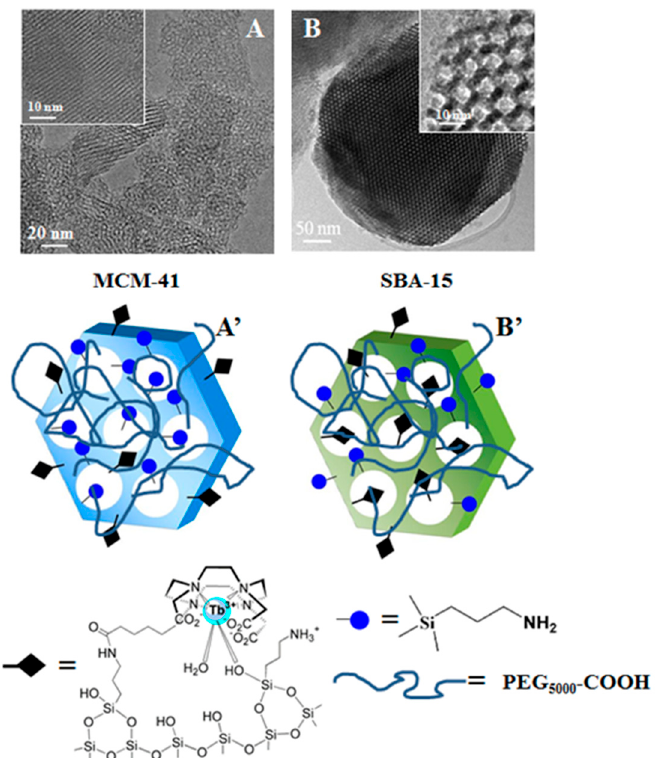
Figure 1. TEM micrographs of MCM-41 ( A ) and SBA-15 ( B ). A schematic view of the distribution of Tb-DO3A chelates on the surface of MCM-14 and SBA-15 is reported in A’ and B’, respectively. The scheme of the interaction between TbDO3A-like chelates and the surface of the organo-modified MSN was assumed after previous studies on similar systems (Reproduced from [25] with permission from The Royal Society of Chemistry).